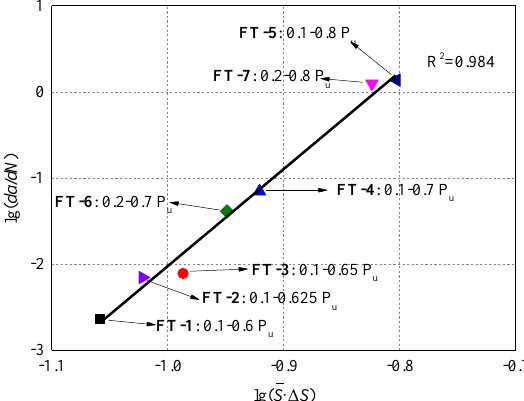
Figure 13. Logarithmic debonding growth rate, da / dN , versus the logarithmic product of the relative load level and relative load amplitude, S S （ ） , of the experimental results.